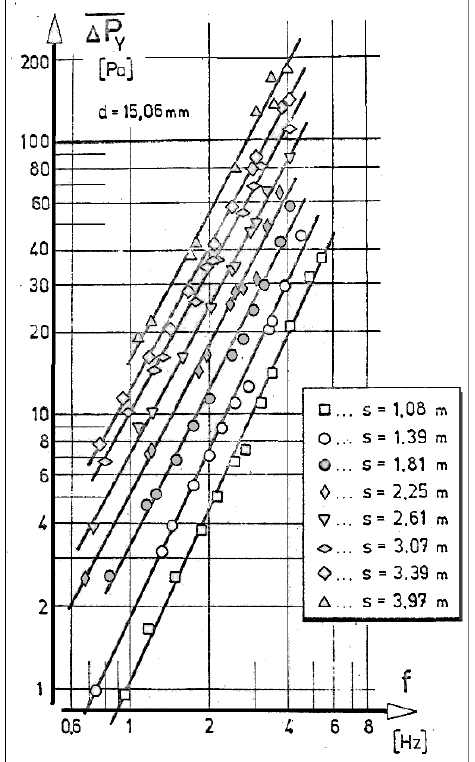
Figure 9. Measured time-mean pressure difference in the settling vessel relative to the atmosphere, here plotted as a function of the piston motion frequency f. The distance s is the piston stroke multiplied by the ratio of the piston and nozzle areas.